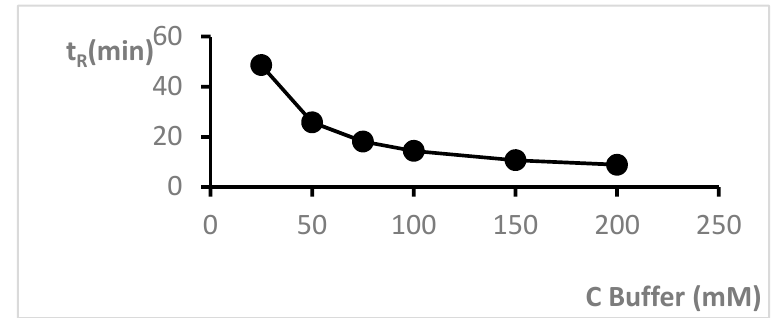
Figure 5. Dependence of t R vs. formate buffer concentration obtained on Luna 5 μ m, SCX 100A, 150 × 4.6 mm column with the mobile phase containing ACN and formate buffer at pH 4.0.